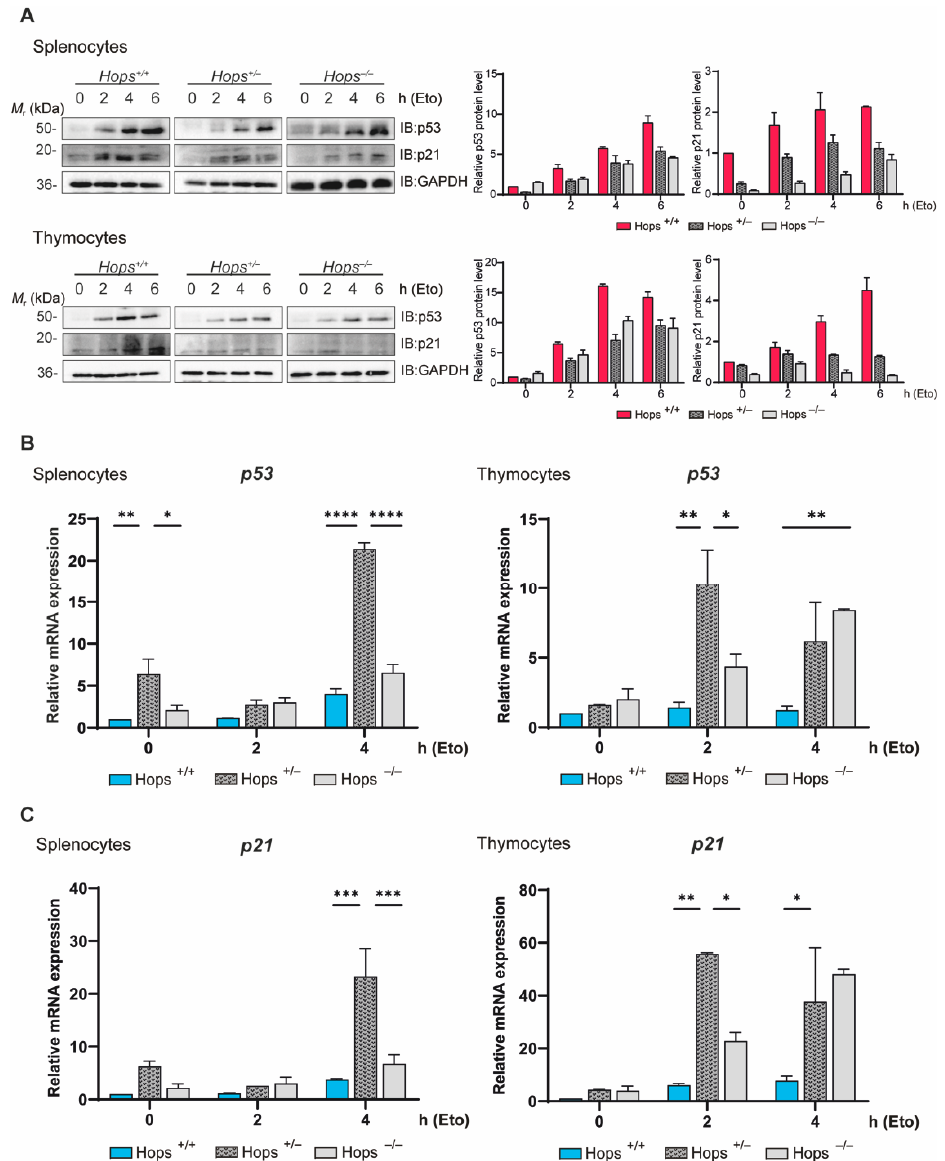
Figure 2. Ex vivo analysis from thymus and spleen after etoposide treatment. ( A ) Western blot analysis of p53 and p21 tumor-suppressor protein amounts in splenocytes (upper panel) and thymocytes (lower panel) from Hops +/+ , Hops +/ − , and Hops − / − mice following etoposide (Eto) treatment at the indicated times (h). GAPDH antibody was used as the loading control. Graphical quantification of Western blots is shown in the right panel. The experiment was performed three times in explanted cells from four different mice. Representative panels are shown. The ( B ) p53 and ( C ) p21 mRNA levels were analyzed by RT-PCR in ex vivo splenocyte and thymocyte cells following etoposide treatment at the indicated times. Data (mean ± SEM of three independent experiments) are represented as normalized transcript expression to β -actin. The p -values were calculated by two-way ANOVA followed by Tukey’s multiple-comparisons test. * p < 0.05, ** p < 0.01, *** p < 0.001, and **** p < 0.0001. In the same conditions, we inspected p53 transcriptional activation in transgenic mouse tissues. In all the genotypes ( Hops +/+ , Hops +/– , and Hops –/– ) the etoposide treatment induced a progressive p53 transcription enhancement (Figure 2B). However, transcriptional activ- ity in heterozygous splenocytes and thymocytes appeared to be deregulated compared to wild-type cells, with levels of p53 expression substantially higher in the heterozygotes at both basal and treated conditions. In response to DNA damage, reduction/lack of Hops